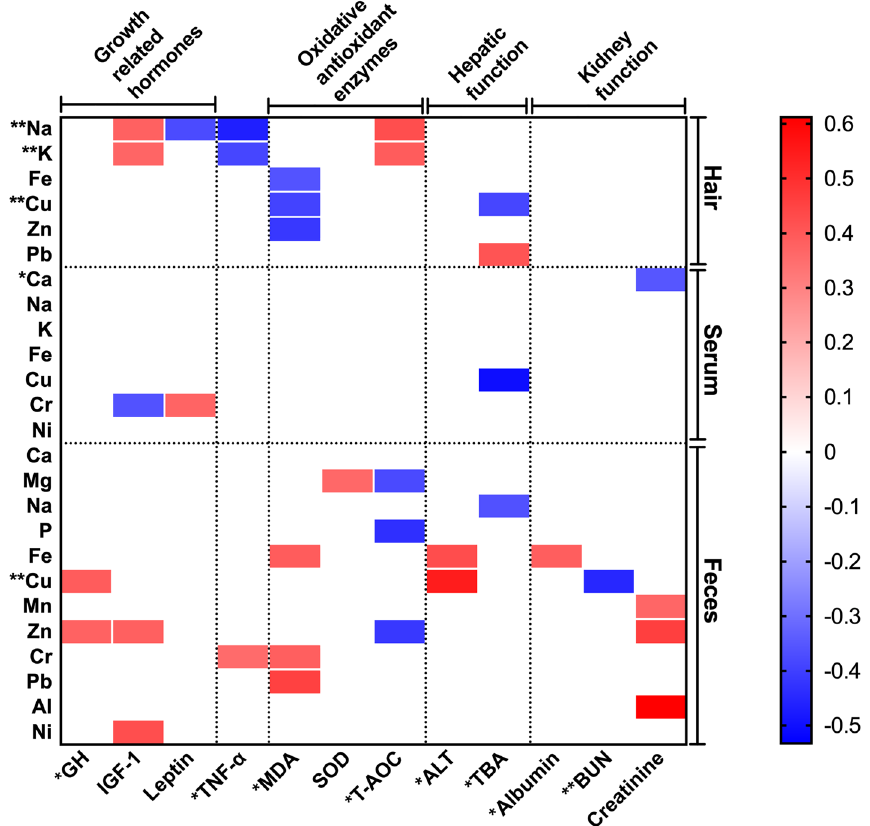
Figure 2. Correlation between ionomics profiles and serum biochemical parameters. The correlation which exited statistical significant were presented. The red represents a positive correlation ( P < 0.05), the blue represents a negative correlation ( P < 0.05), and the white shows that the correlation was not significant ( P > 0.05). * , ** significantly different among each copper diet, * denote P < 0.05, ** denote P <